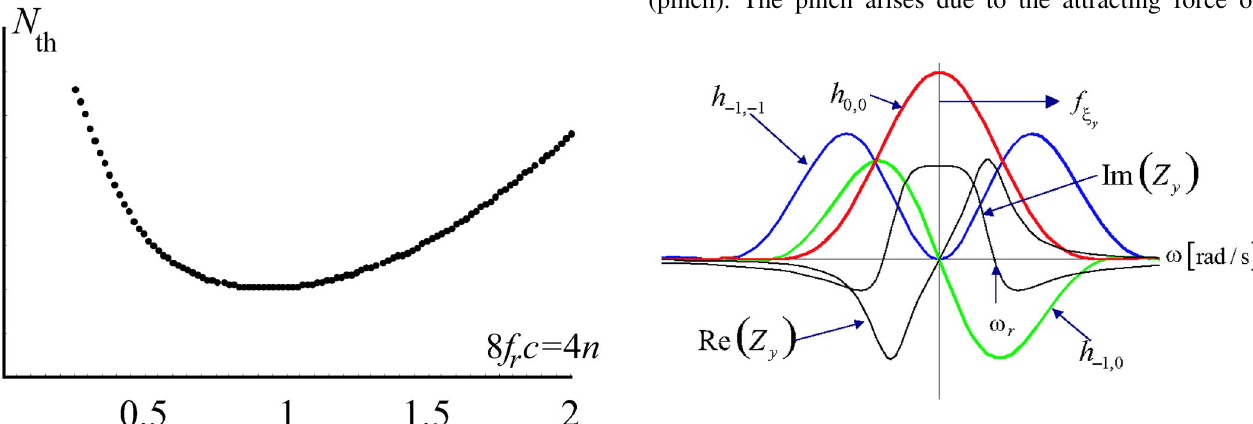
FIG. 56. Intensity threshold for a classical broadband resonator near n (cid:8) 1 = 2 [84,106].